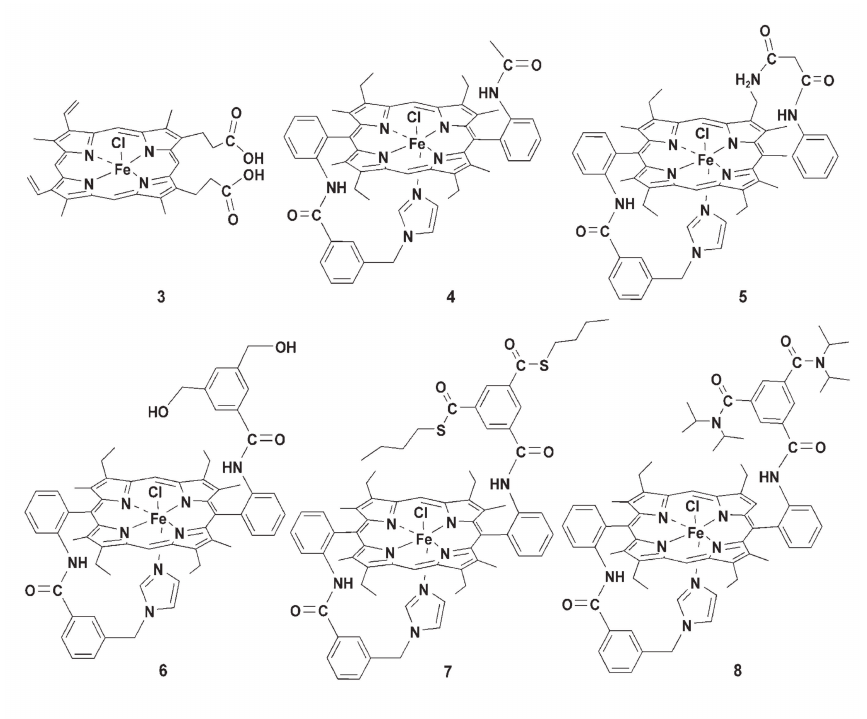
Figure 7: Structures of haemin (3) and synthetic derivatives (4 – 8) used in the study by Wang et al. [96]. Reprinted with permission from Ref. [96]. Copyright © 2008, John Wiley and